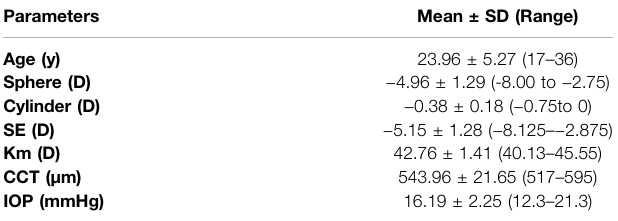
TABLE 1 | Demographic and clinical characteristics ( n =